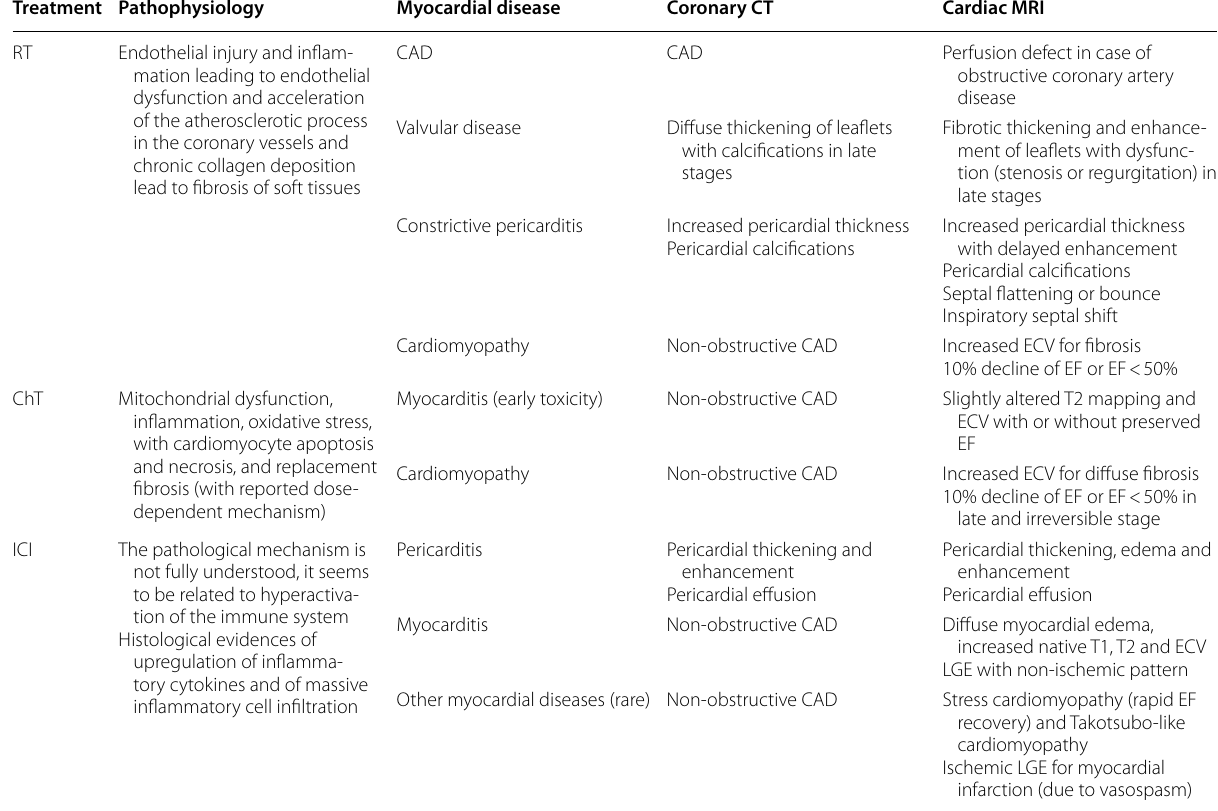
RT, radiation therapy; ChT, chemotherapy; ICI, immune checkpoint inhibitors; CAD, coronary artery disease; EF, ejection fraction; T1, native T1 mapping; ECV, extracellular volume fraction; LGE, late gadolinium enhancement